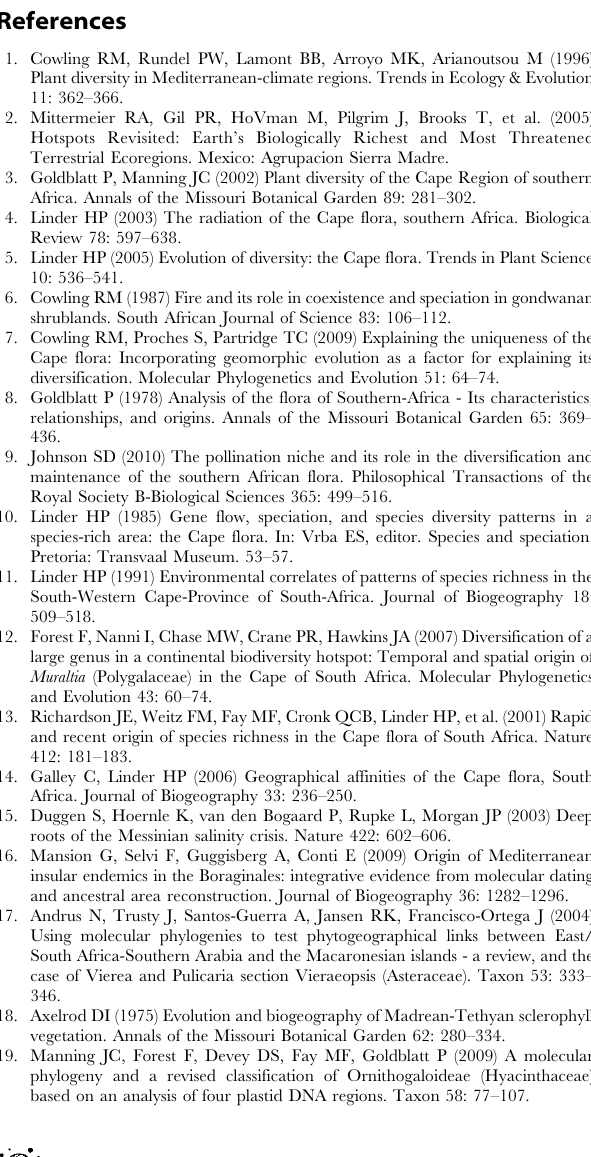
Table S2 Voucher information and GenBank accession num- bers for sequences used in this study. Table S3 Divergence time estimates and associated confidence intervals for selected